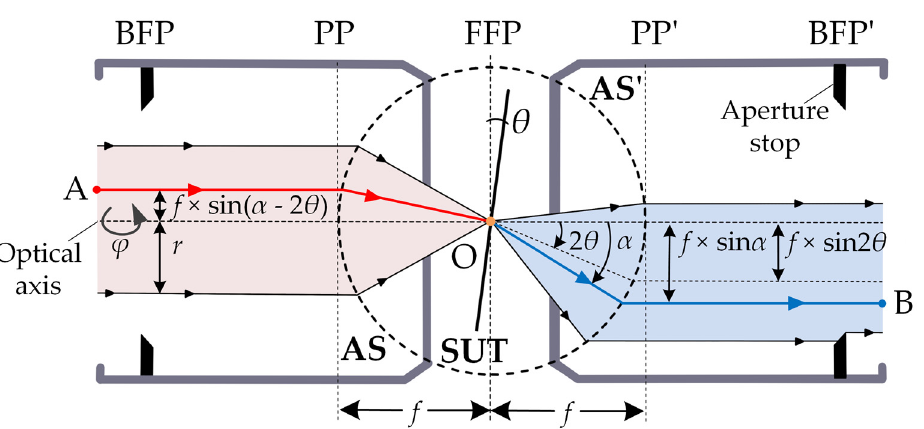
Figure 2. Schematic of ray tracing when the structure of the microscope’s objective with a high NA meets the sine condition of Abbe is expanded to measure the inclination plane. The left side of the SUT is the incident light path, and the right side of SUT is the reflected light